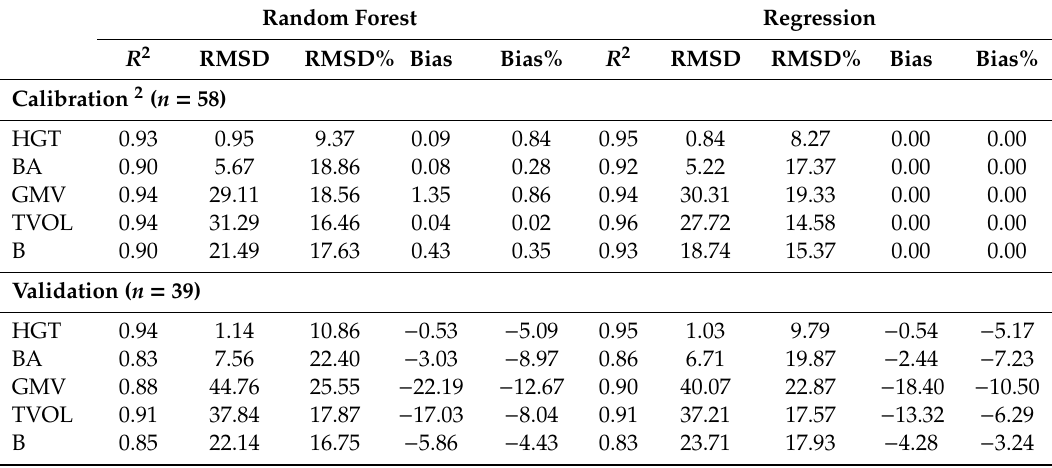
Table 3. Evaluation statistics for ALS-based prediction of forest attributes 1 . Random